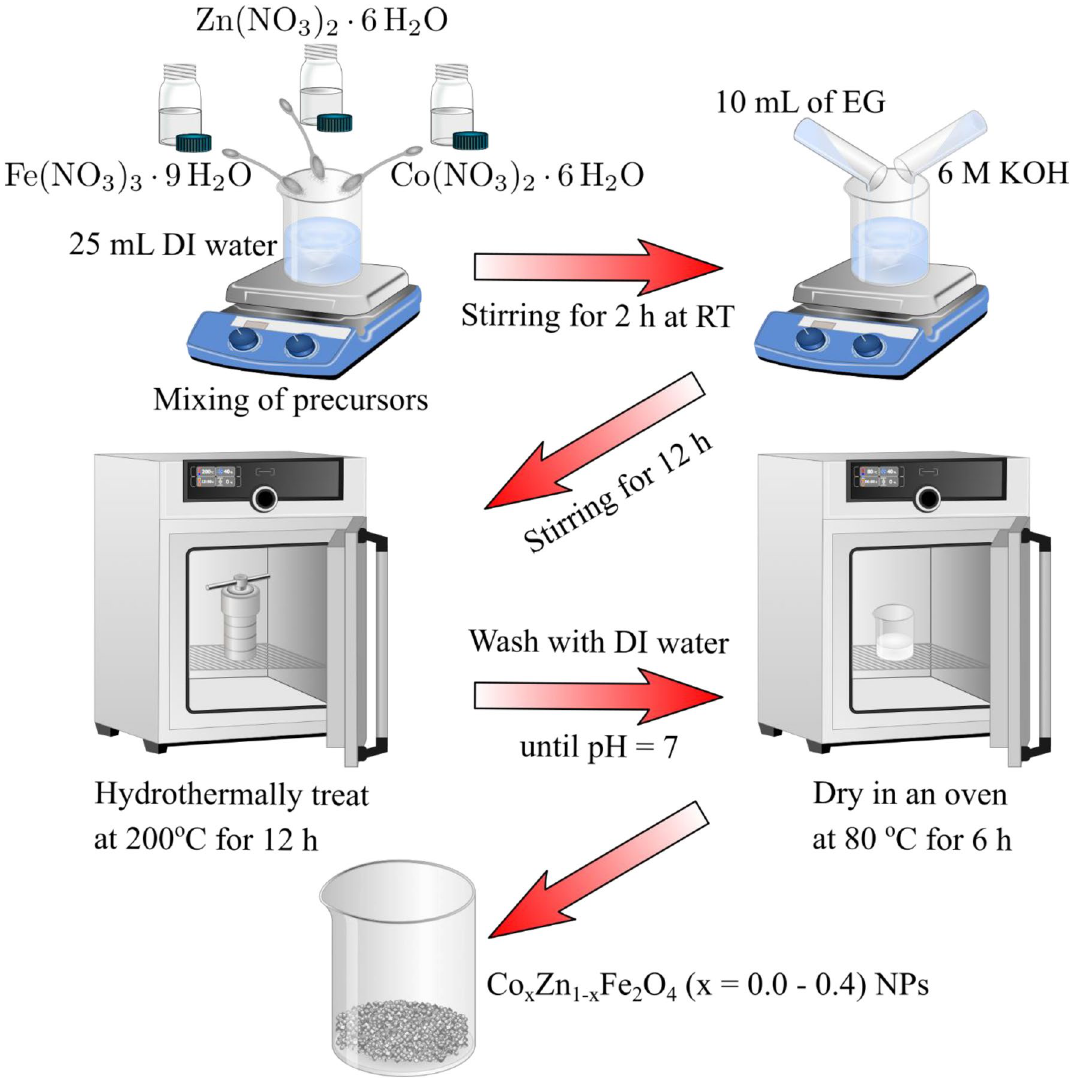
Figure 1. Synthesis of Co x Zn 1−x Fe 2 O 4 (x = 0.0–0.4) NPs by a hydrothermal